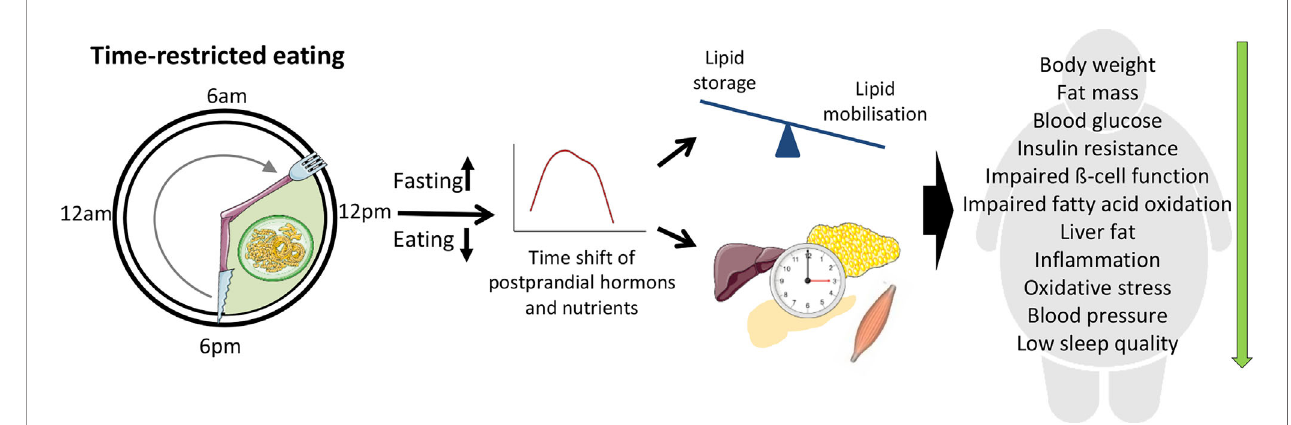
FIGURE 1 | Bene fi cial effects of time-restricted eating (TRE) for individuals with metabolic disturbances. During TRE, elongation of the fasting period leads to the depletion of liver glycogen stores and a metabolic switch from lipid/cholesterol synthesis and fat storage to mobilization of fat through fatty acid oxidation and fatty acid-derived ketones. Modi fi cation of fasting – eating cycle can also directly in fl uence peripheral clock which in turn contribute to the metabolic changes. The clock entrainment in peripheral tissues can be induced by the time shift of postprandial changes of metabolic hormones and nutrients acting via a number of molecular pathways as well as by the alterations of AMP/ATP ratio and cellular NAD+